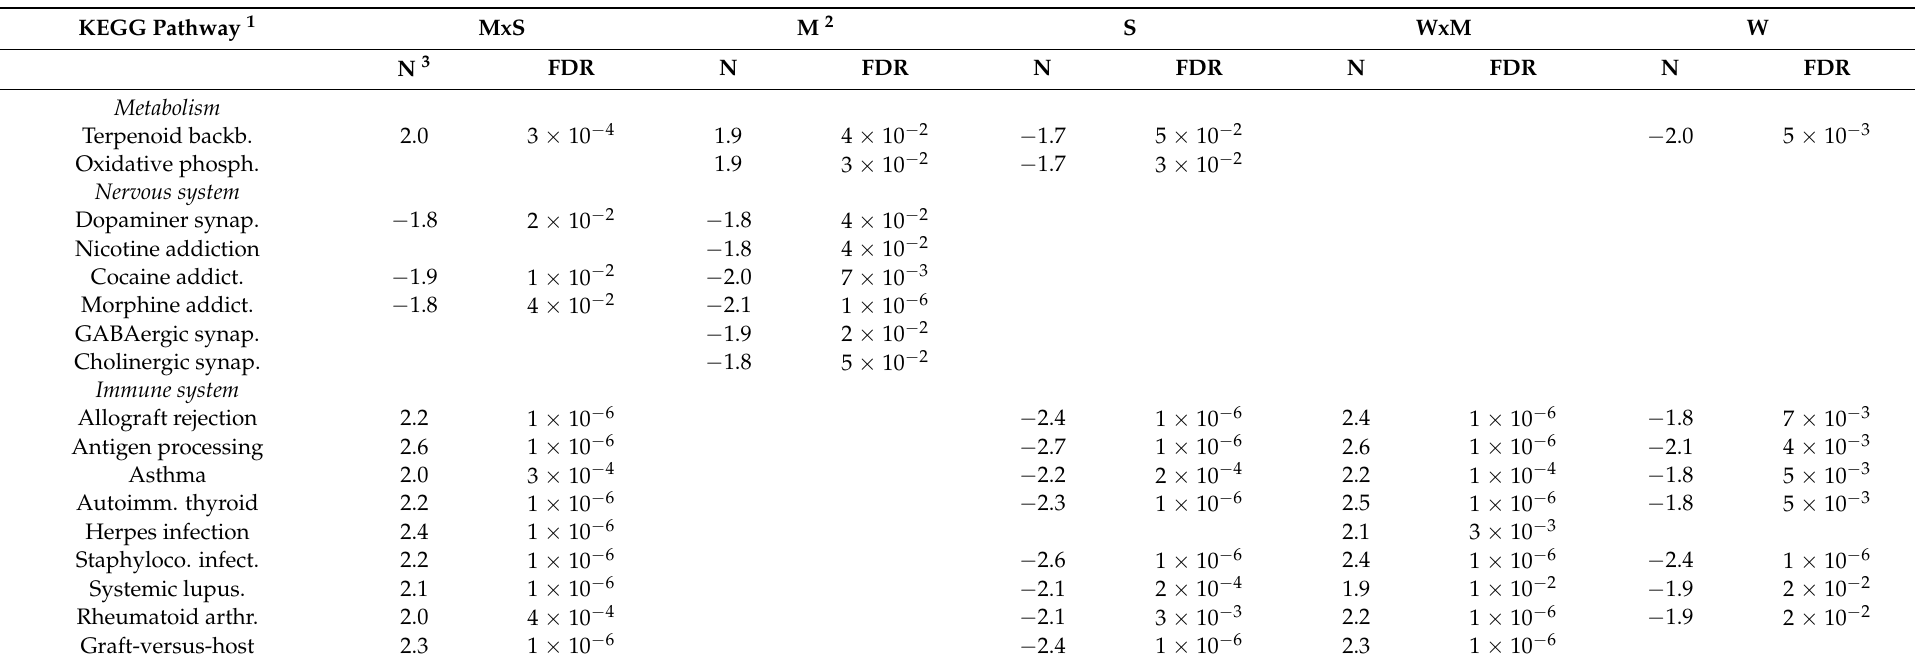
Table 1. Hippocampal pathways enriched by at least one factor including interactions (x) or the main effects of weaning (W), maternal immune activation (M), and sex (S) at a FDR-adjusted p -value < 0.05 and a normalized enrichment score |NES| > 1.5. KEGG Pathway